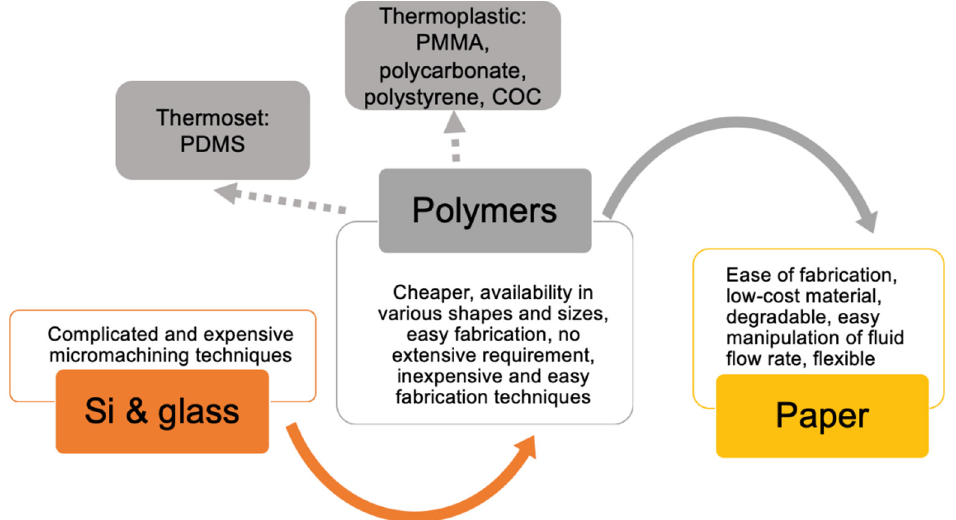
Figure 4. A schematic diagram showing the change in materials with time in microfluidics and their disadvantages/advantages.